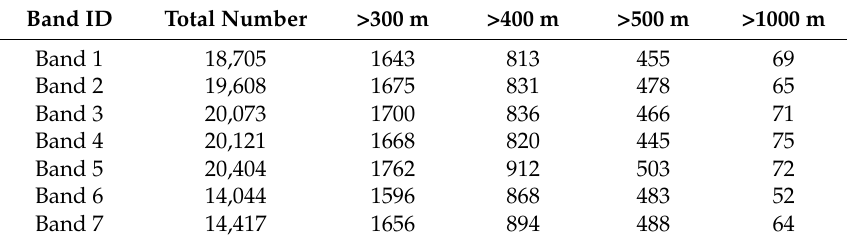
Table 5. Numbers of detected lines with different lengths using the TOA reflectance data with a resolution of 30 m.